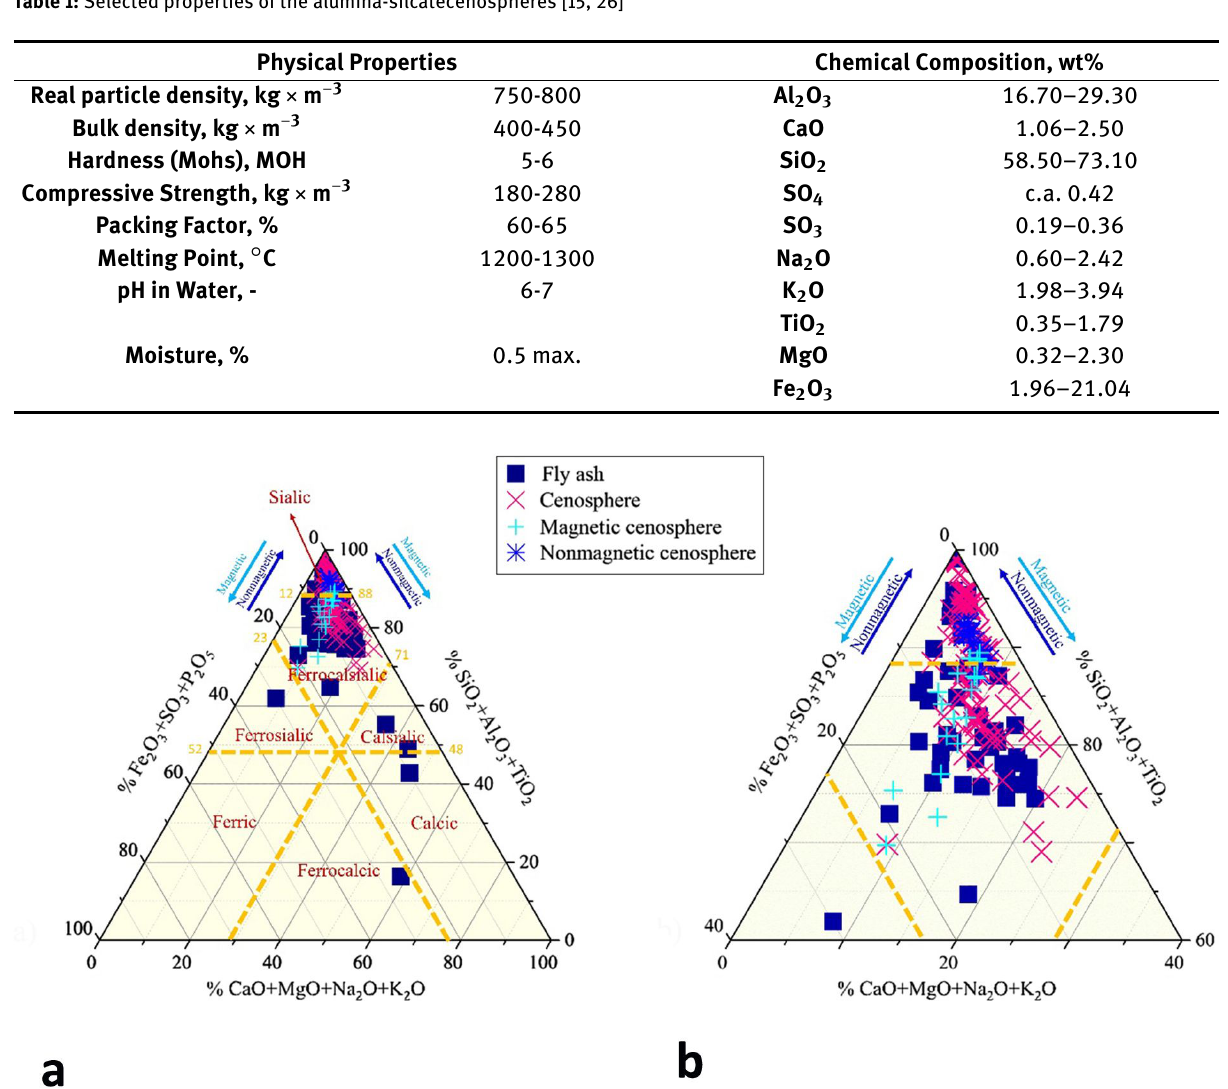
Table 1: Selected properties of the alumina-silcatecenospheres [15, 26]